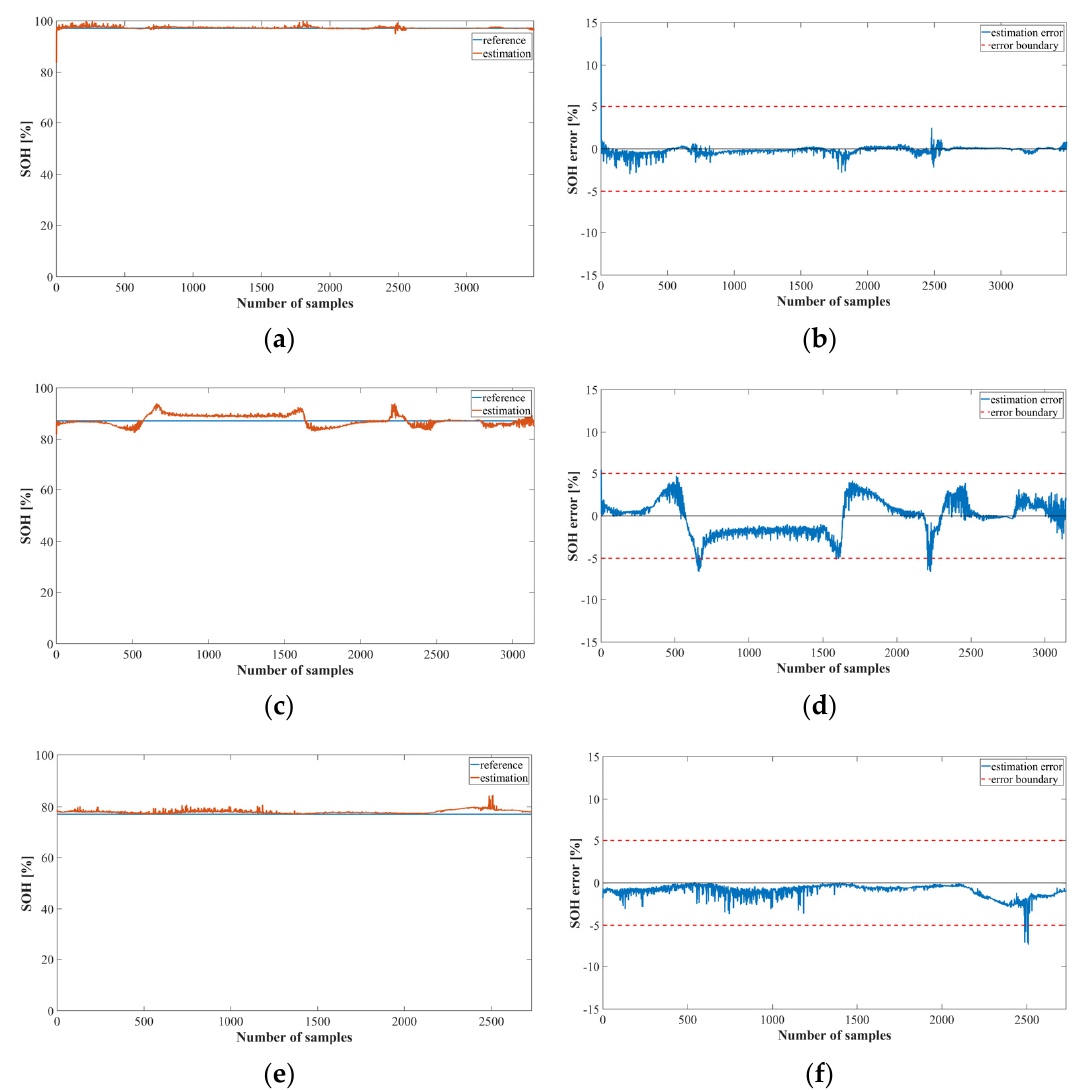
Figure 14. SOH estimation results for Method 2 using the LSTM (Oxford dataset): ( a ) SOH estimation result; ( b ) error at cycle 6; ( c ) SOH estimation result; ( d ) error at cycle 28; ( e ) SOH estimation result; ( f ) error at cycle 70.